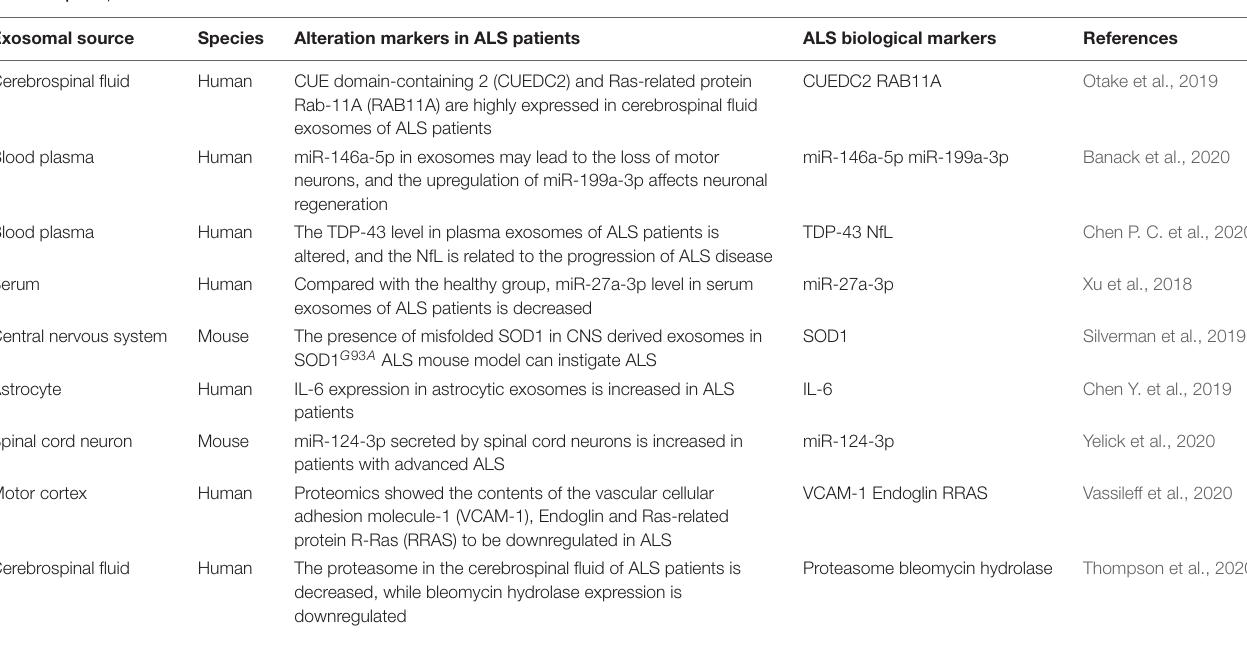
TABLE 1 | The potential biomarkers of